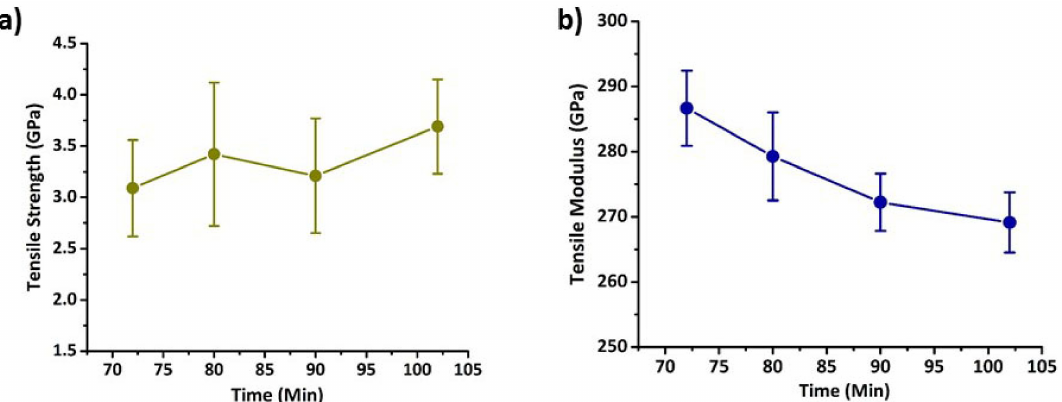
Figure 4. Mechanical properties of carbon fibres with respect to stabilization residence times ( a ) Tensile strength ( b ) Tensile